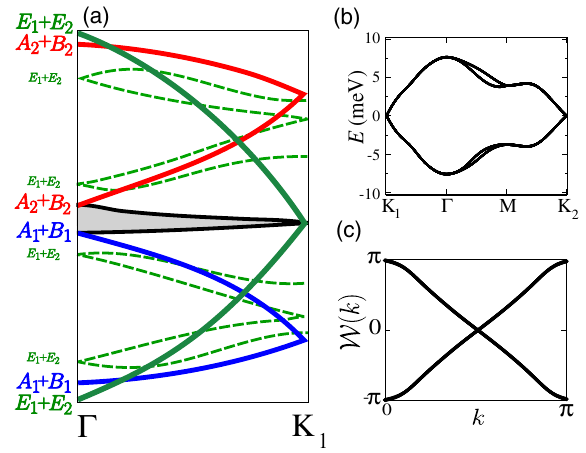
FIG. 12. (a) Sketch of the elementary band representation along Γ → K 1 taking into account the 32 bands closest to the charge neutrality point and without allowing avoided crossing between same-symmetry Bloch states. Blue, red, and green lines refer to Bloch states that at Γ transform like A 1 þ B 1 , A 2 þ B 2 , and E 1 þ E 2 , respectively. Should we allow for avoided crossings, close to charge neutrality we would obtain the four flatbands shown as black lines surrounding the shaded region. (b) The FBs obtained by a model tight-binding Hamiltonian that includes only the solid bands of (a). The details of this Hamiltonian are given in Appendix B. (c) Wilson loop corresponding to the four bands in (b) fully